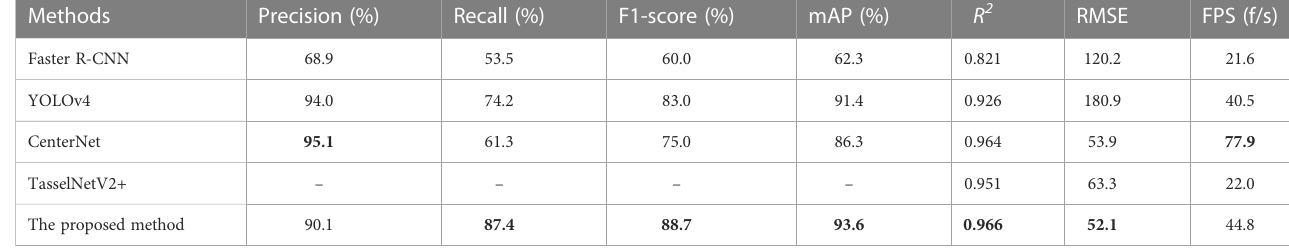
TABLE 3 Comparison of experimental results between the proposed method and other classical networks. Methods